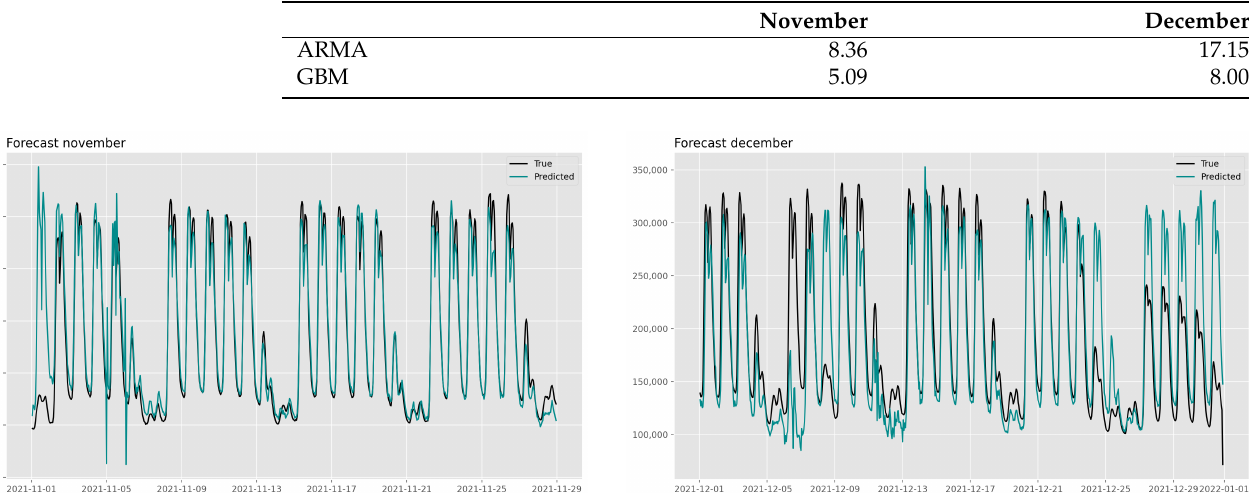
Table 2. MAPE for ARMA and GBM for November and December.